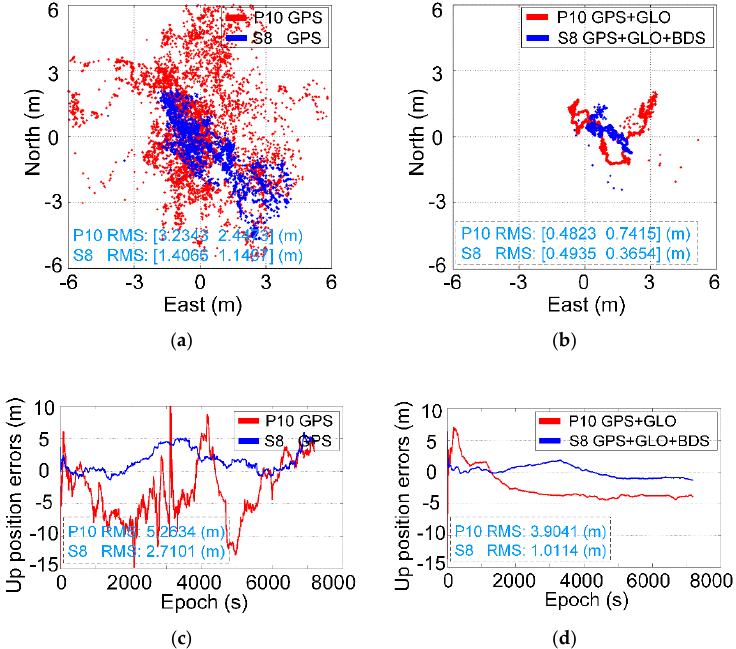
Figure 12. ( a , b ) are the comparison of GPS and GNSS (GPS, GLONASS, and BDS) horizontal position errors; ( c , d ) are the vertical position errors for smartphone S8 and P10, respectively.